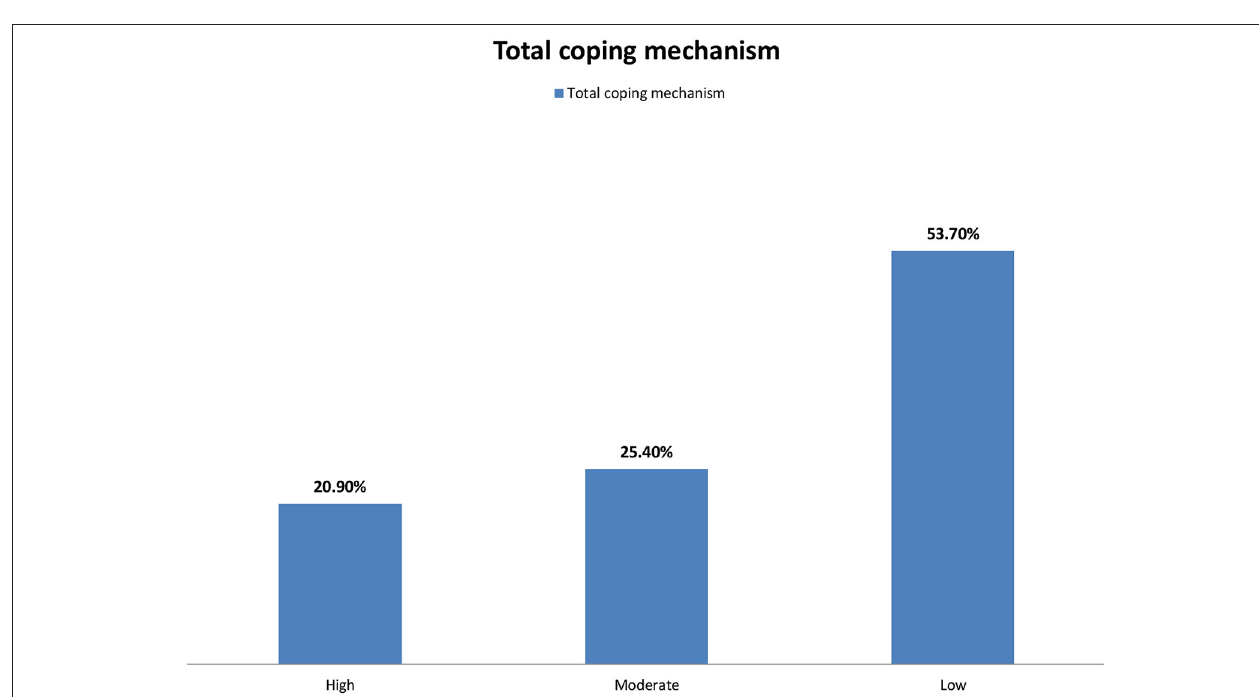
FIGURE 2 | Distribution of the studied critical care nurses according to their total coping mechanism ( n =